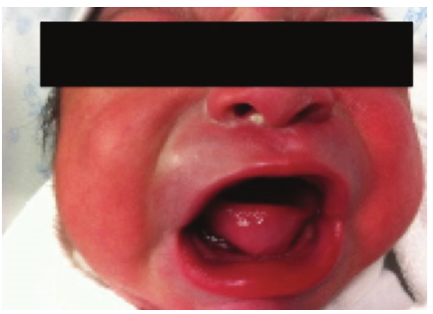
Figure 3: Magnetic resonance imaging of the fetal cyst.